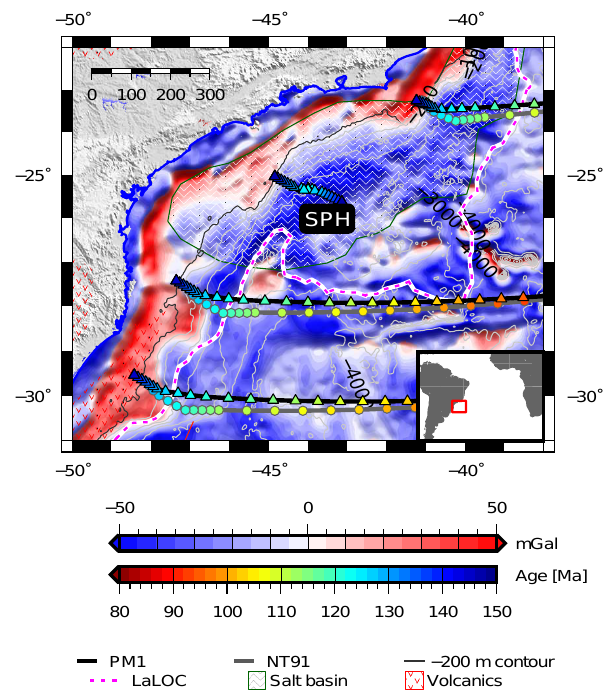
Fig. 12. Age-coded flowlines plotted on filtered free-air gravity basemap (offshore) for the Santos Basin segment on South Ameri- can margin. SPH: S˜ao Paulo High in the outer Santos Basin. Note that initial NW–SE relative extensional direction as predicted by the plate model is perpendicular to the Santos margin hingeline (cf. Meisling et al., 2001, for details on the crustal structure in along the inner Santos Basin margin) and does conform to observed structural patterns in the extended continental crust of the SPH (cf. Chang, 2004). Legend/symbology and filter as in Fig.